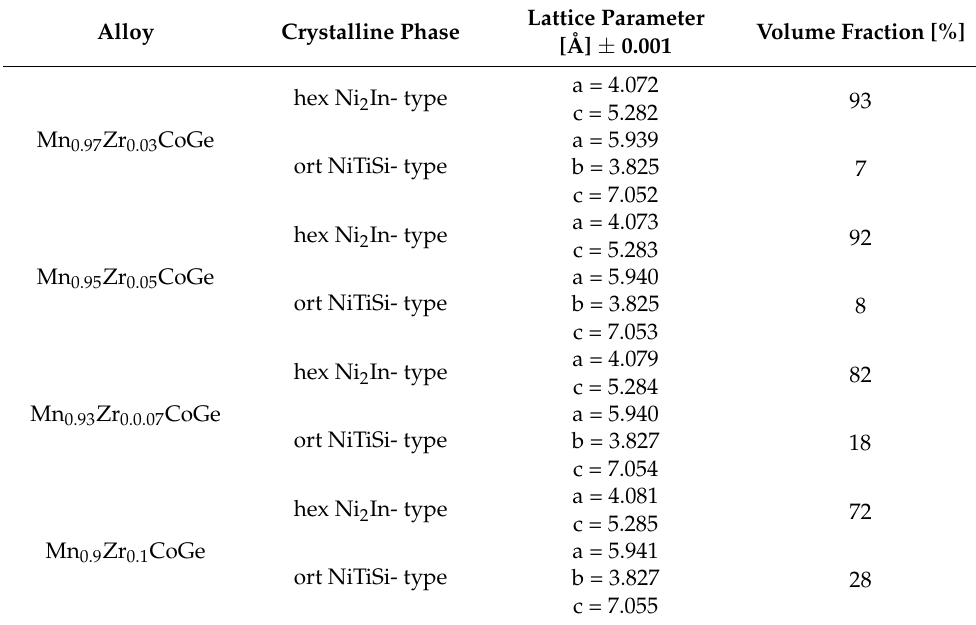
Table 1. The results of the Rietveld analysis for all investigated